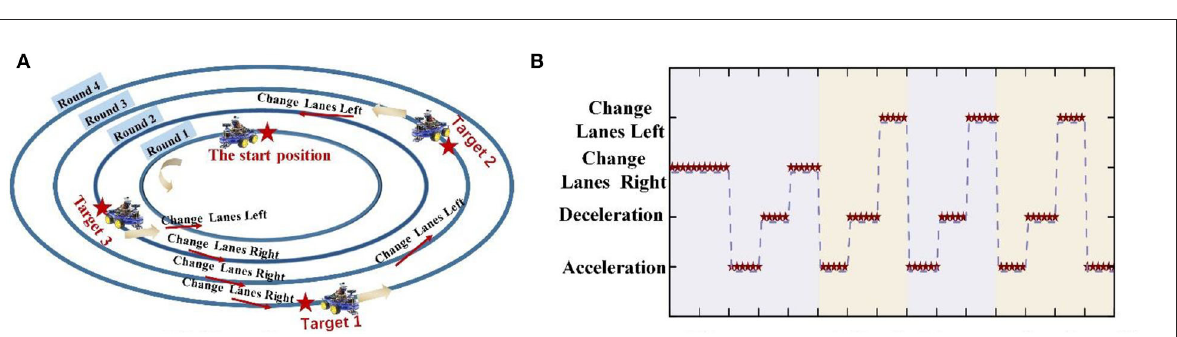
FIGURE8 Offline classification accuracies and standard deviations under the three methods.